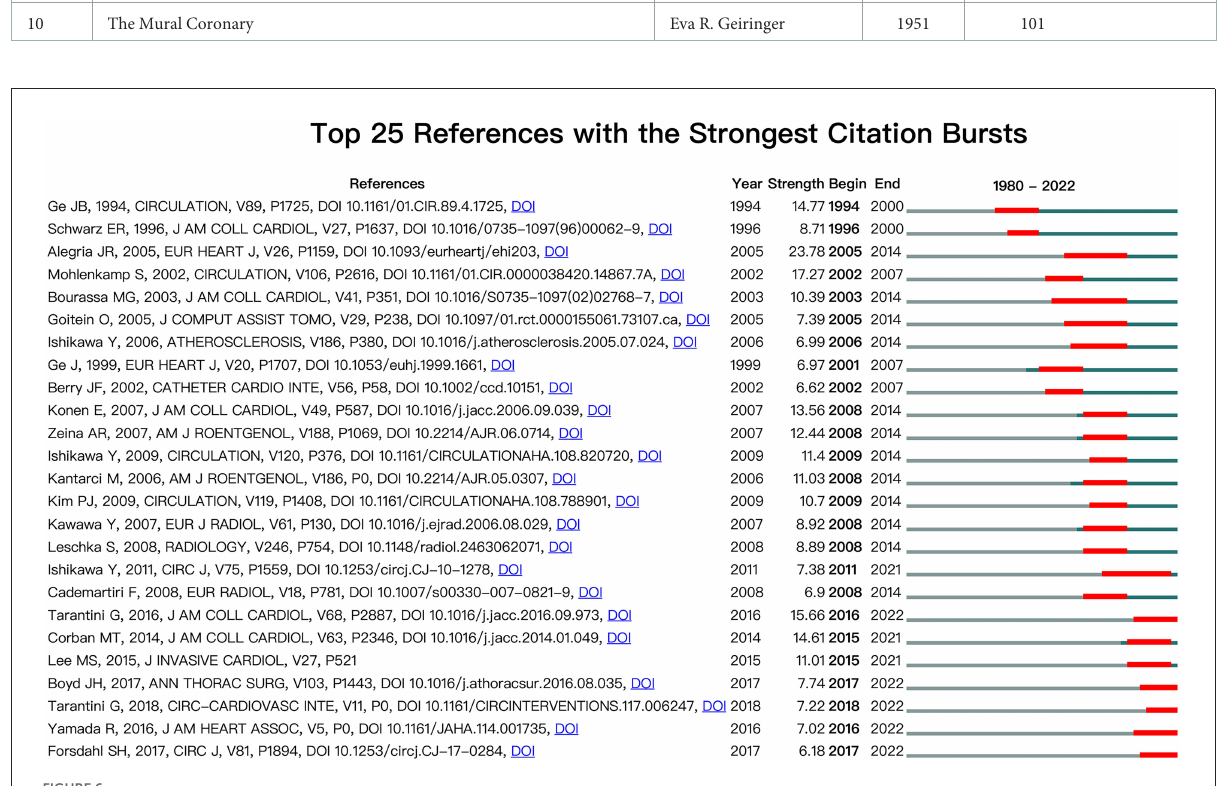
the name of cluster #3, has also been studied. Dipyridamole